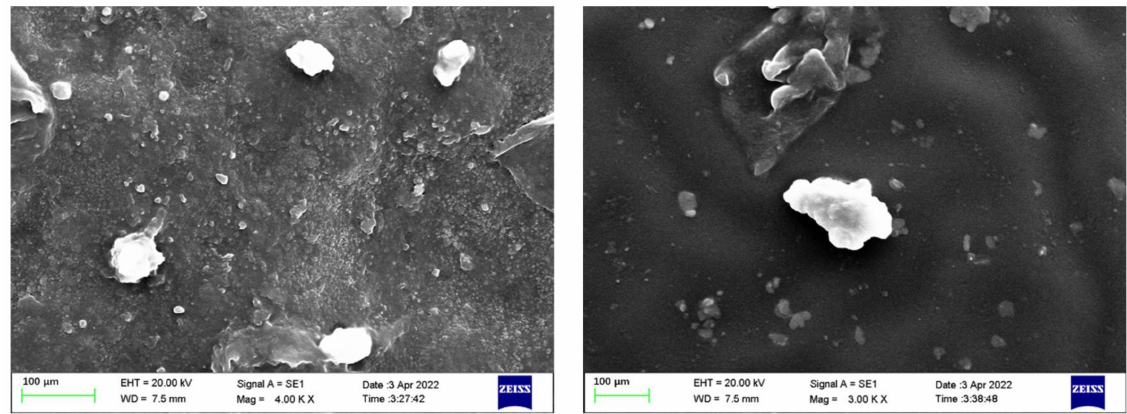
Figure 8. Adhesion of large particle size to the proppant’s surface.